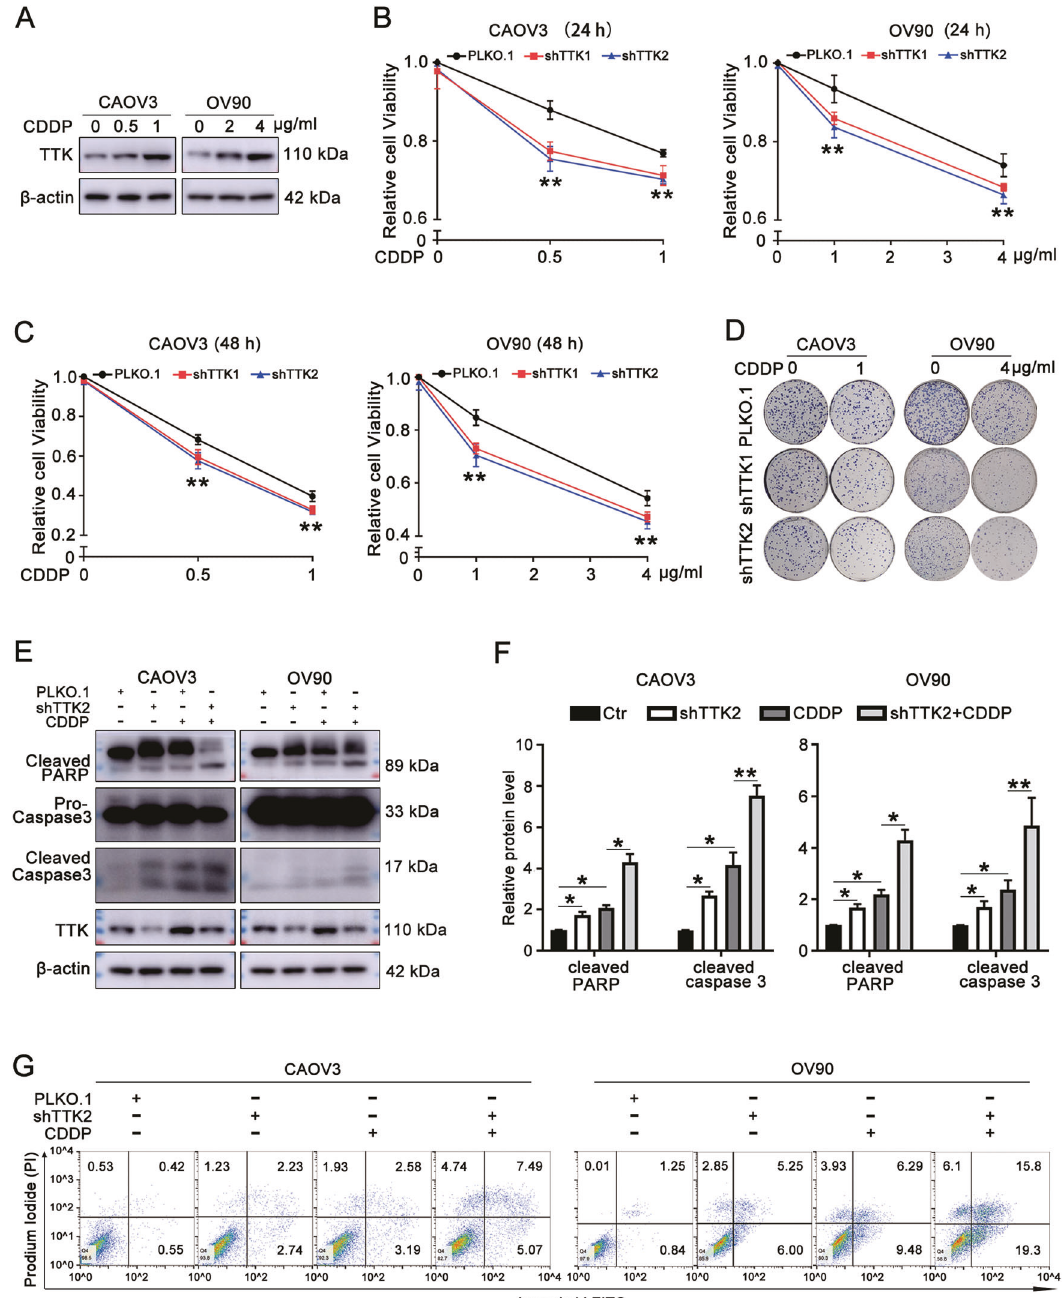
Fig. 4 TTK silencing enhances cisplatin sensitivity in ovarian cancer cells. A Western blotting was performed to detect the TTK protein level in CAOV3 and OV90 cells treated with different concentrations of cisplatin (0, 0.5, or 1 μ g/ml for CAOV3 and 0, 2, or 4 μ g/ml for OV90) for 48 h. B − D CAOV3 and OV90 cells stably transfected with PLKO.1 or the TTK shRNA (shTTK1 and shTTK2) were treated with different concentrations of CDDP (0, 0.5, or 1 μ g/ml for CAOV3 and 0, 1, or 4 μ g/ml for OV90). The MTT assay was performed at 24 h ( B ) and 48 h ( C ) and the colony formation assay ( D ) was performed to evaluate the effect of TTK on CDDP sensitivity. E − G CAOV3 and OV90 cells stably transfected with PLKO.1 or shTTK2 were treated with 2 or 4 μ g/ml CDDP for 48 h. E , F Western blot assays were conducted to assess the relative protein levels of cleaved PARP, cleaved caspase-3, and TTK normalized to β -actin. G Flow cytometry was used to detect apoptotic cells (data are mean ± SEM, * P < 0.05, ** P < 0.01, n = CAOV3 and OV90 cells (Fig. 6B and Supplementary Fig. S5B). In TTK depletion inhibits autophagy by activating the mTOR addition, immuno fl uorescence staining showed that TTK knock- signaling pathway in ovarian cancer cells down reduced the number of LC3B puncta and TTK over- Additional experiments were performed to further con fi rm that expression LC3B (Fig. 6C and TTK is involved in the autophagy pathway. TTK silencing Supplementary Fig. S5C). The level of LC3-II was increased to a decreased the level of the LC3-II protein (Fig. 6A and Supplemen- greater extent following chloroquine (CQ) treatment, suggesting tary Fig. S5A), while TTK overexpression increased LC3-II levels in